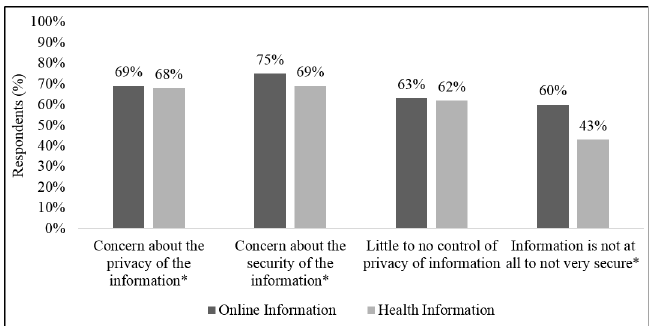
Fig 1. Privacy& securityof generalonline information vs. health information. Concernaboutprivacy and securityof information was measuredon a 1–10scale.Percentages representrespondents who selected6–10,